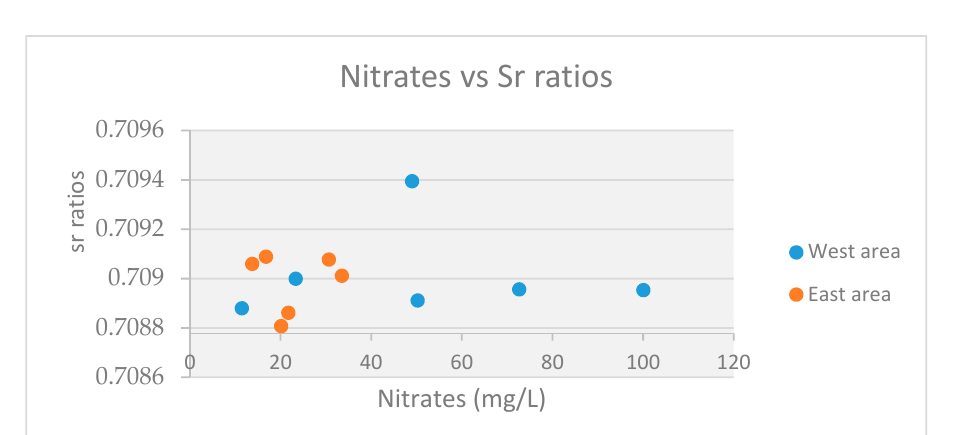
Figure 7. Cr (VI) vs. δ 53 Cr plot.